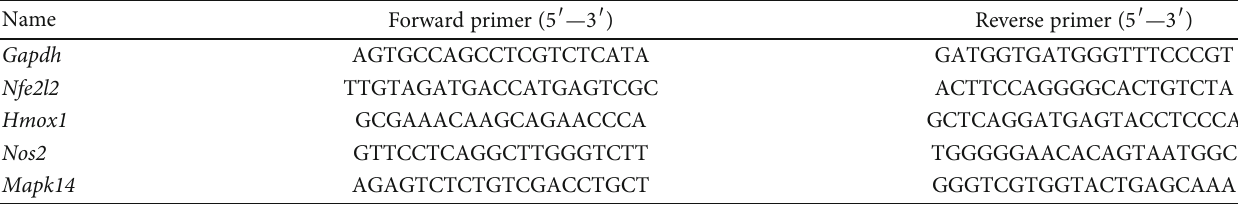
Table 1: Primer sequences of genes analyzed in real-time PCR.